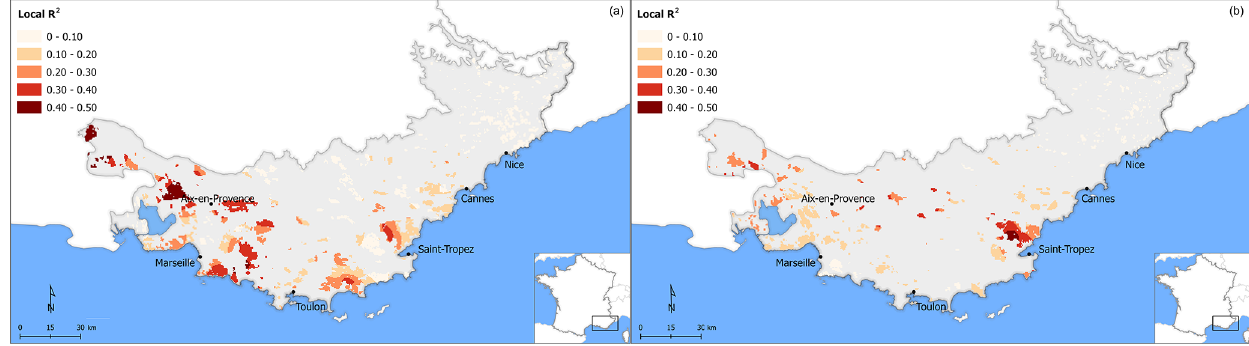
Figure 16. Spatial distribution of local R 2 between the burned area and percent cover of the sclerophyllous vegetation for 1970–1994 (a) and 1995–2019 (b)